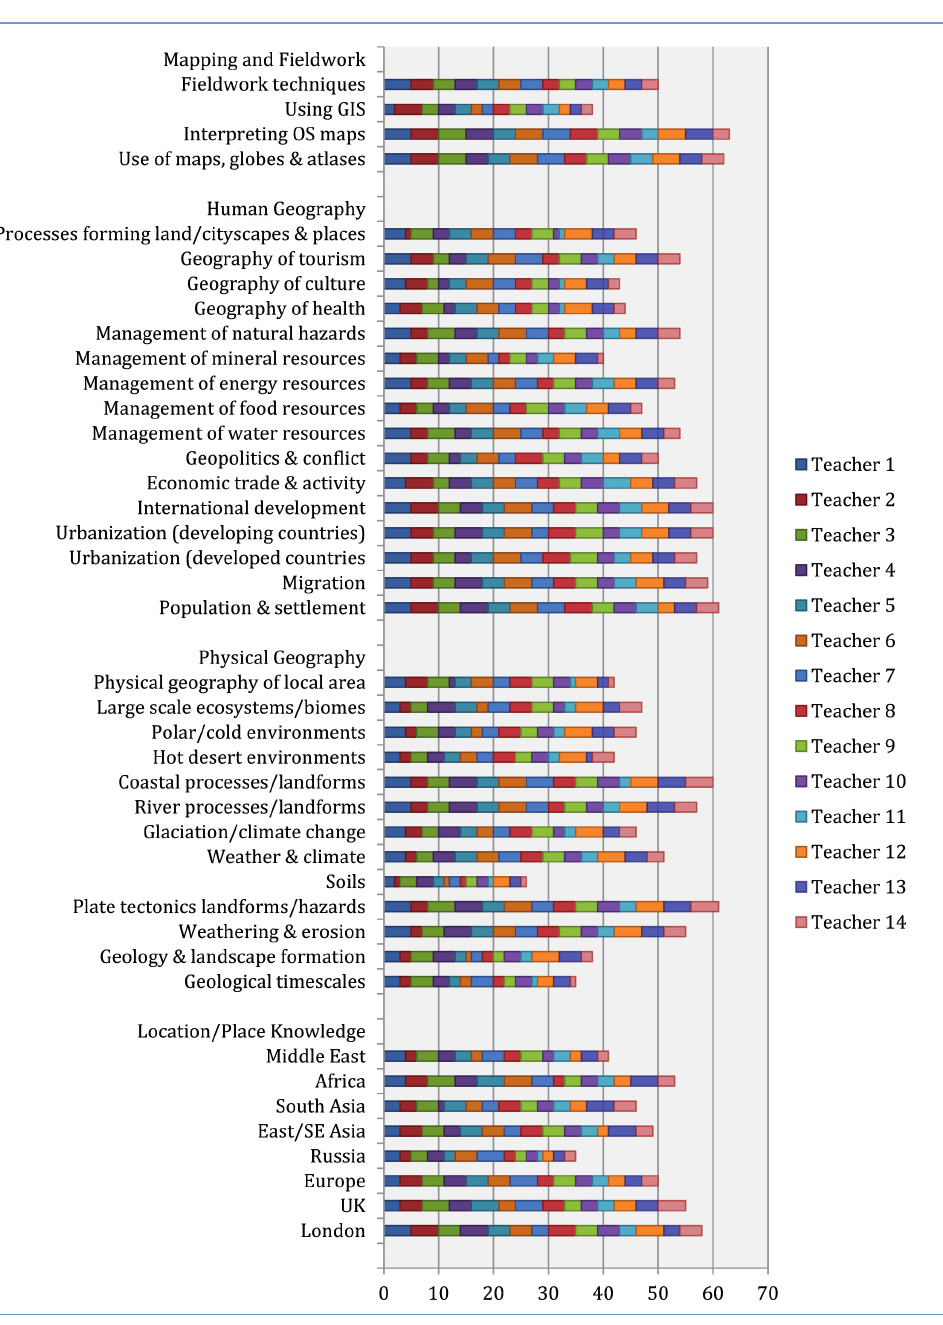
Figure 7: Secondarysubjectknowledgeconfidencebynationalcurriculumtopic(baseline). Cumulativeforeachtopic:teachers’self-scoreoflevelofsubjectknowledgeandunderstanding.